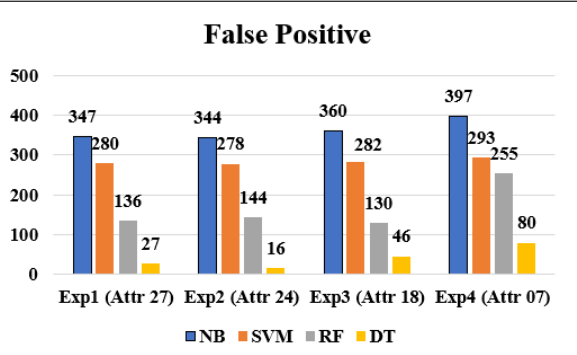
Figure 5. Rate of False Positive.